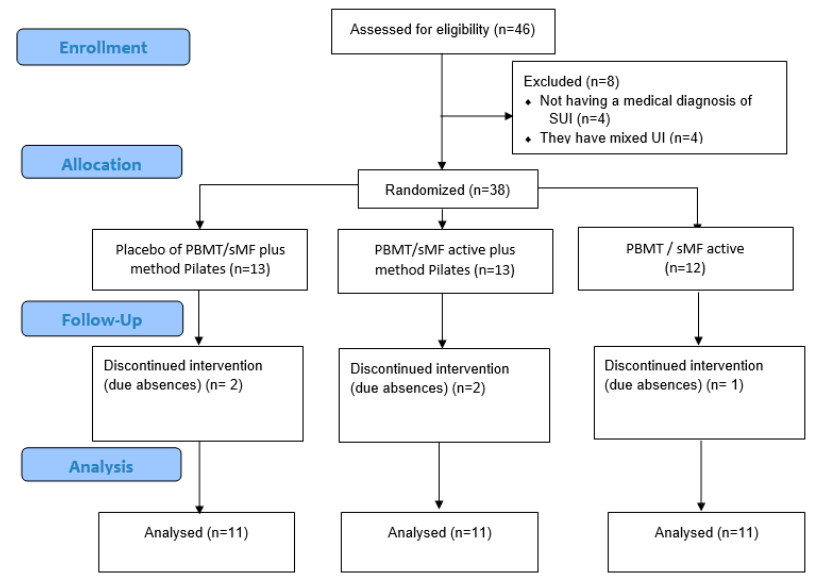
Figure 1. CONSORT flow diagram of the study shows the flow diagram of the study, including enrolment, randomization, intervention allocation, follow-up, and data analysis of the three groups. Table 3. Demographic characteristics of study